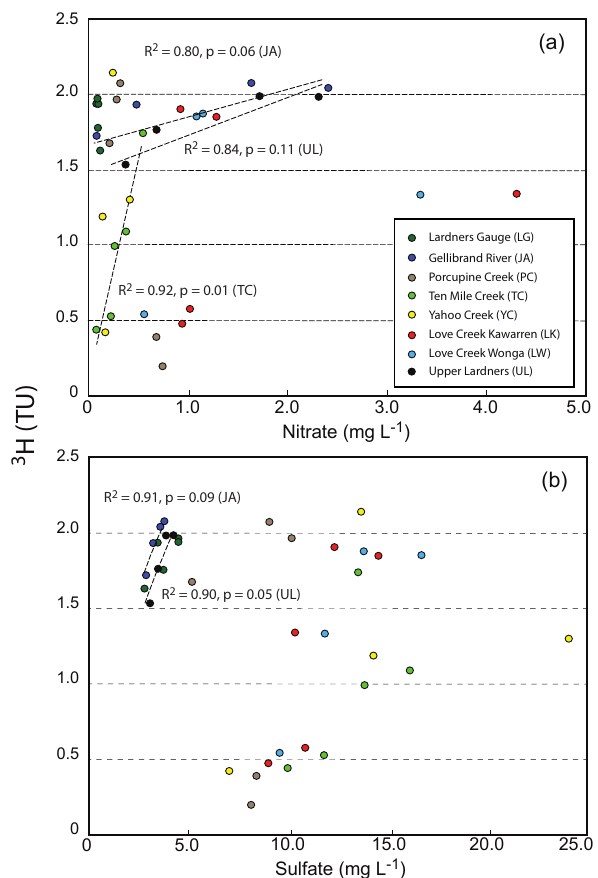
Figure 6. 3 H activities as function of nitrate concentrations (a) and sulfate concentrations (b) . Data from Supplement. Strong ( R 2 > 0.7) correlations